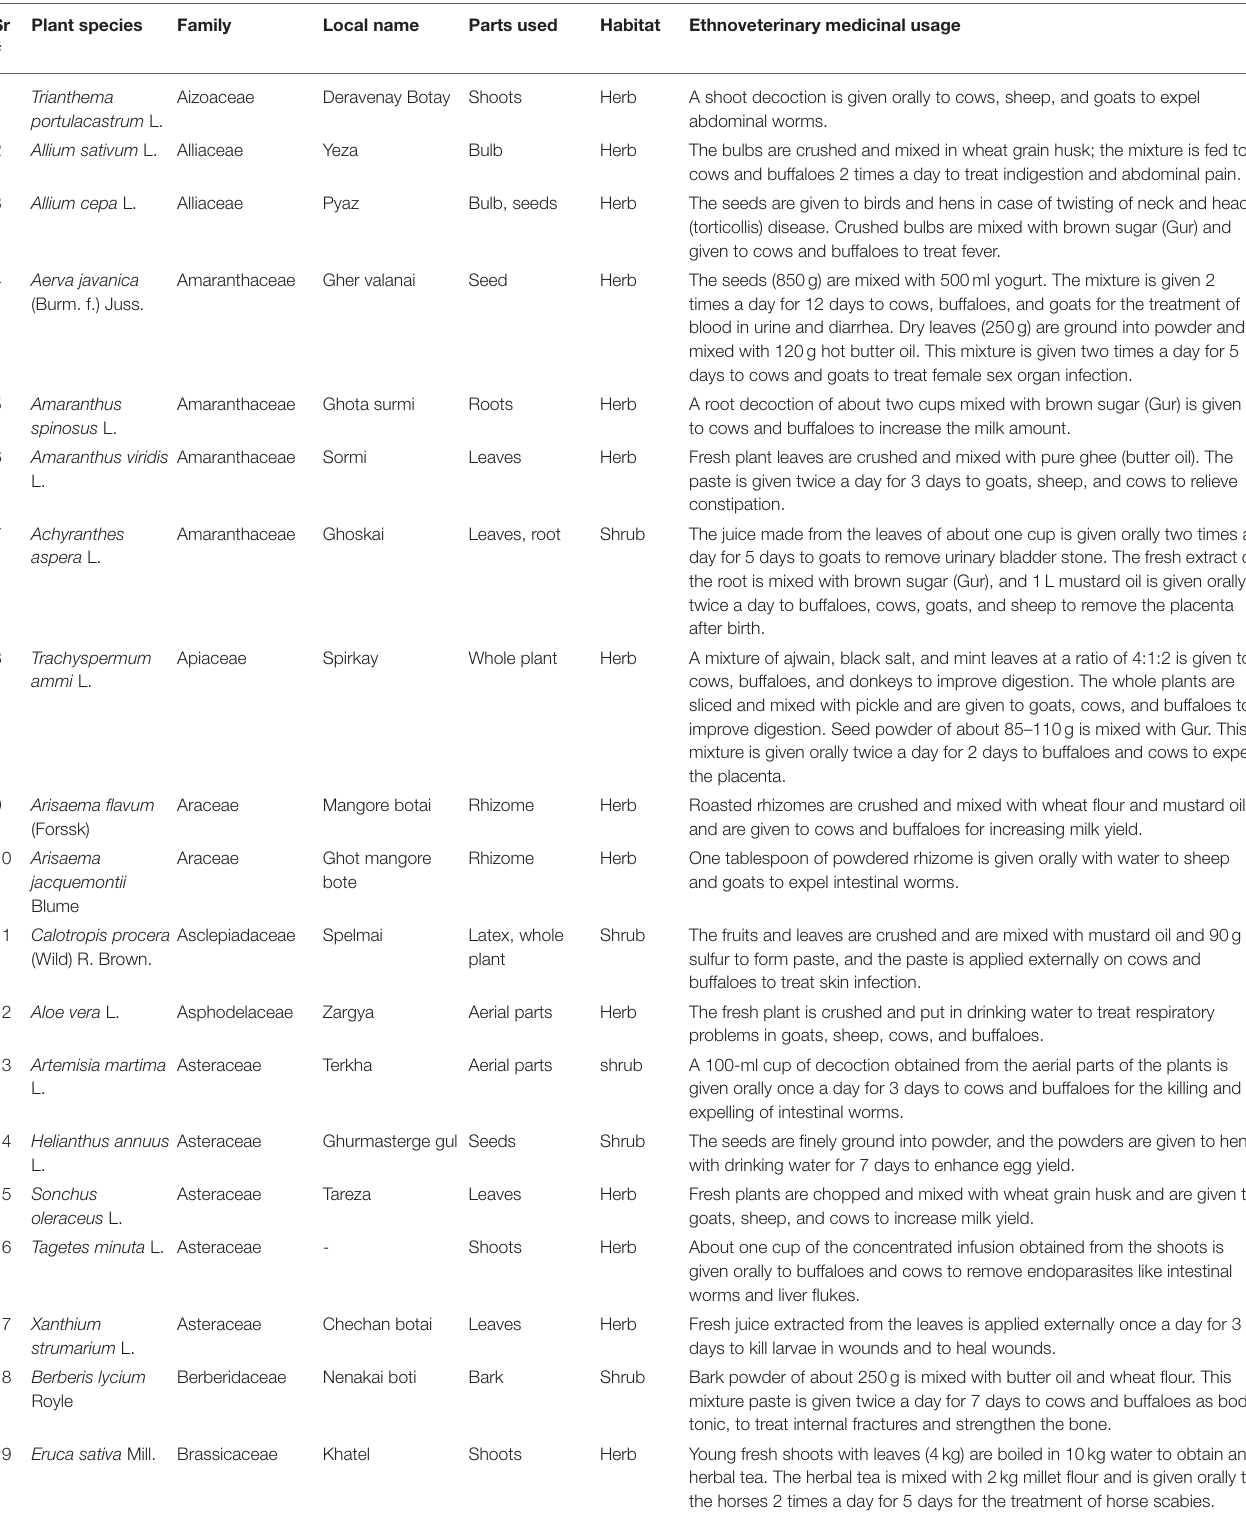
TABLE 2 | List of ethnoveterinary plants (EVPs) used by tribes for healing of different ailments in North Waziristan, Pakistan. Sr